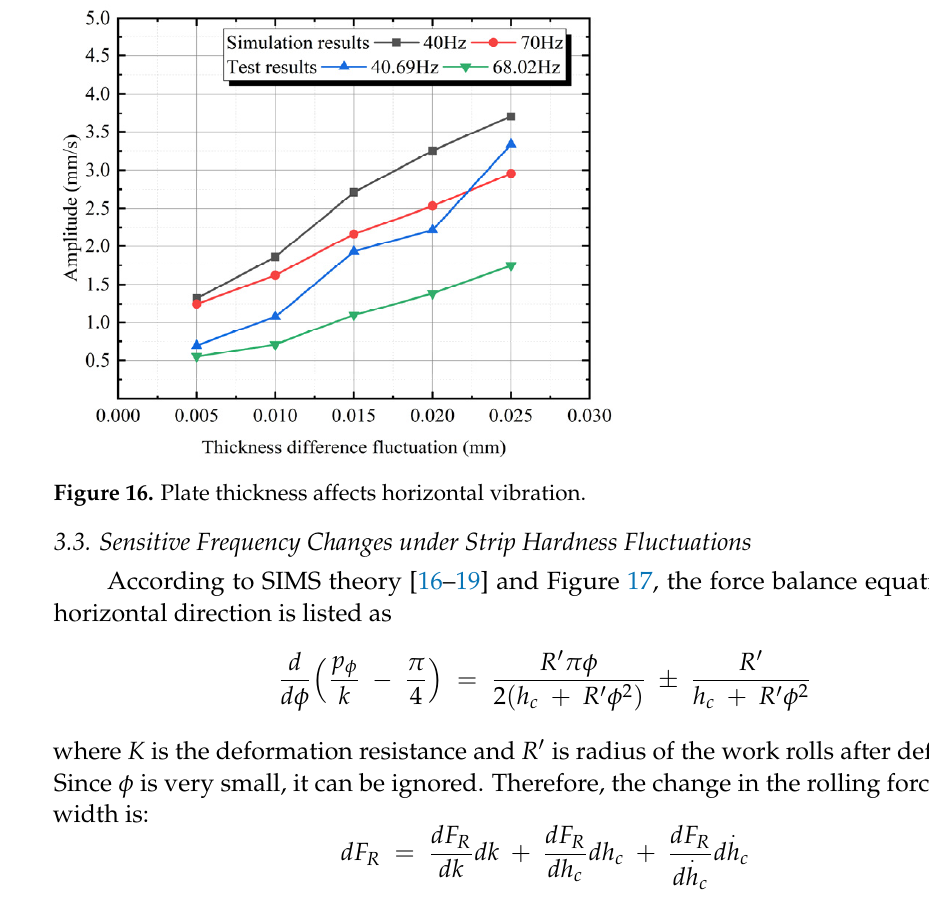
Figure 15. Plate thickness affects axial vibration.